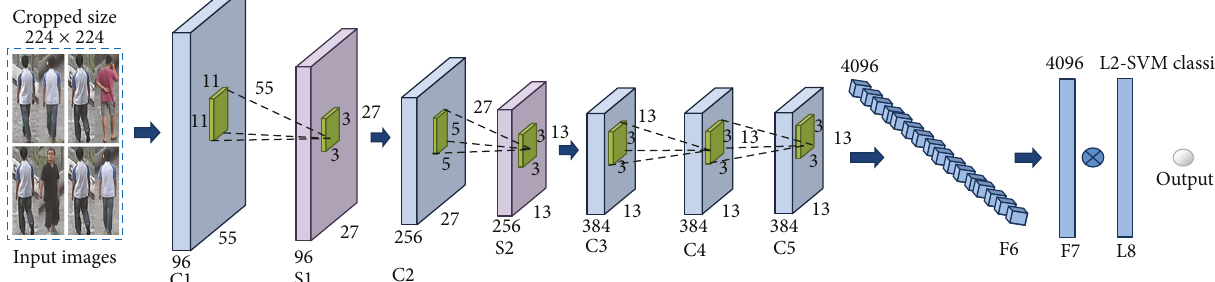
Figure 3: The framework of our proposed model. Both of positive and negative pairs are randomly selected as input images. The first to fifth layers are convolution layers and subsampling layers with Relu activation. Sixth and seventh layers are fully connected layers with 4096 neural units. The top layer is linear L2-SVM layer instead of traditional softmax layer to measure the similarity of input